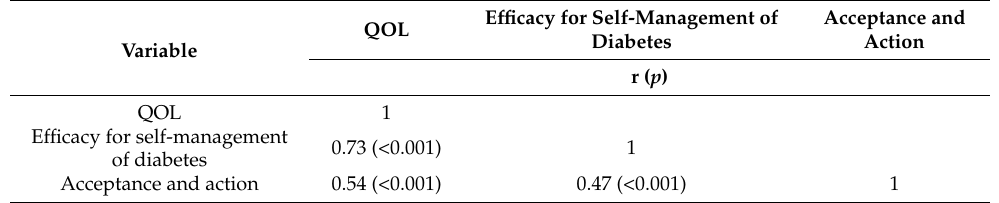
Table 4. Correlation of the Variables ( N = 111).